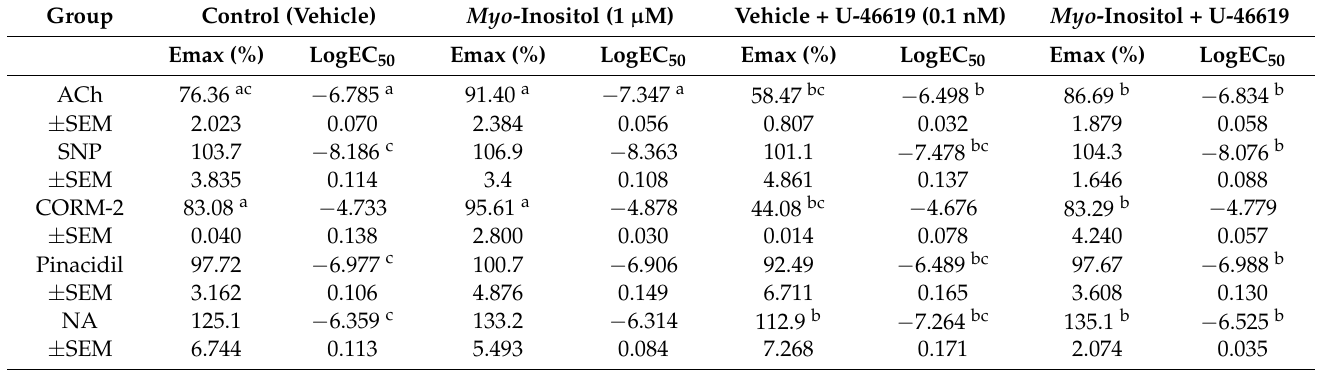
Table 1. Vascular response to the vasodilators: acetylcholine (ACh), sodium nitroprusside (SNP), CO releasing molecule (CORM-2), pinacidil, and the vasoconstrictor noradrenaline (NA).